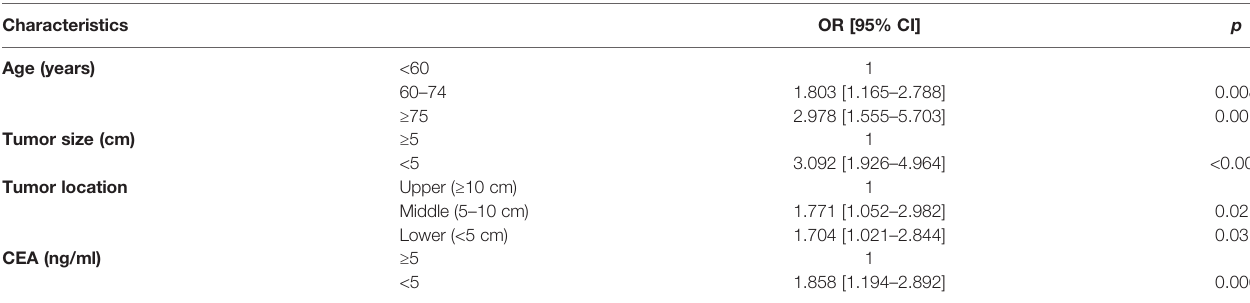
TABLE 3 | Multivariate logistic regression analysis in the development set.